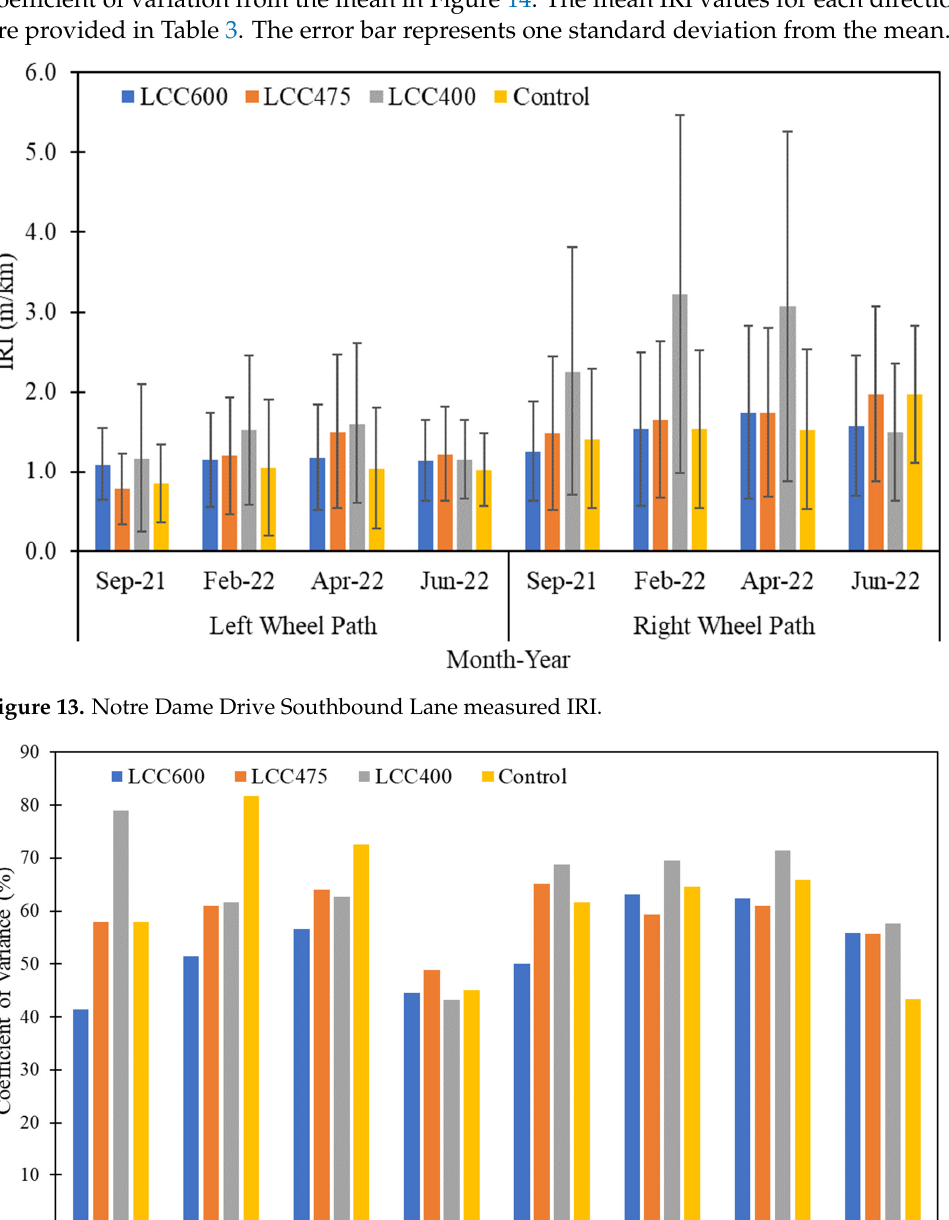
Figure 12. Erbsville measured IRI coe ffi cient of variation from the mean.